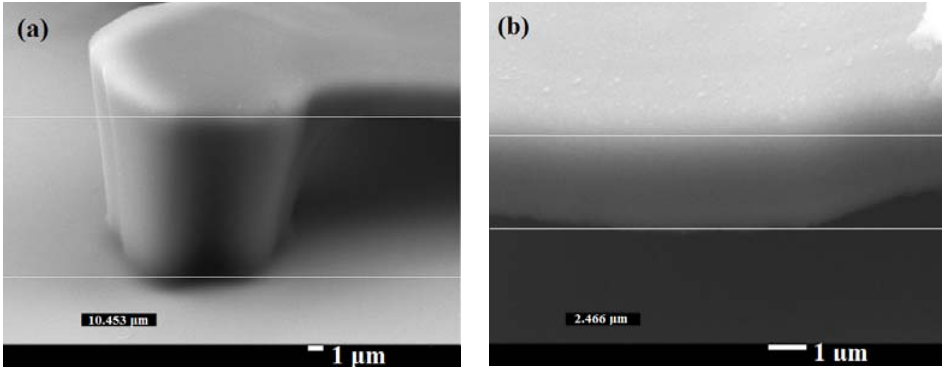
Figure 6. SEM pictures of one leg and enlarged view of platform.